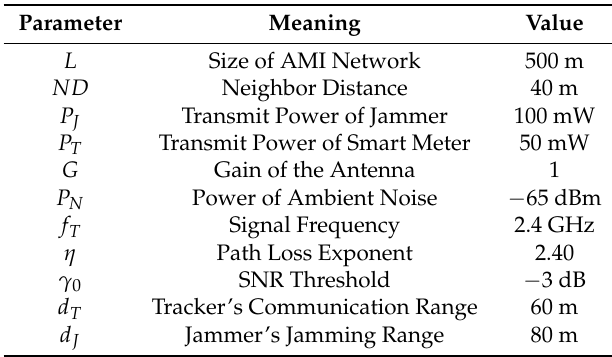
Table 2. Definition of the parameters in the